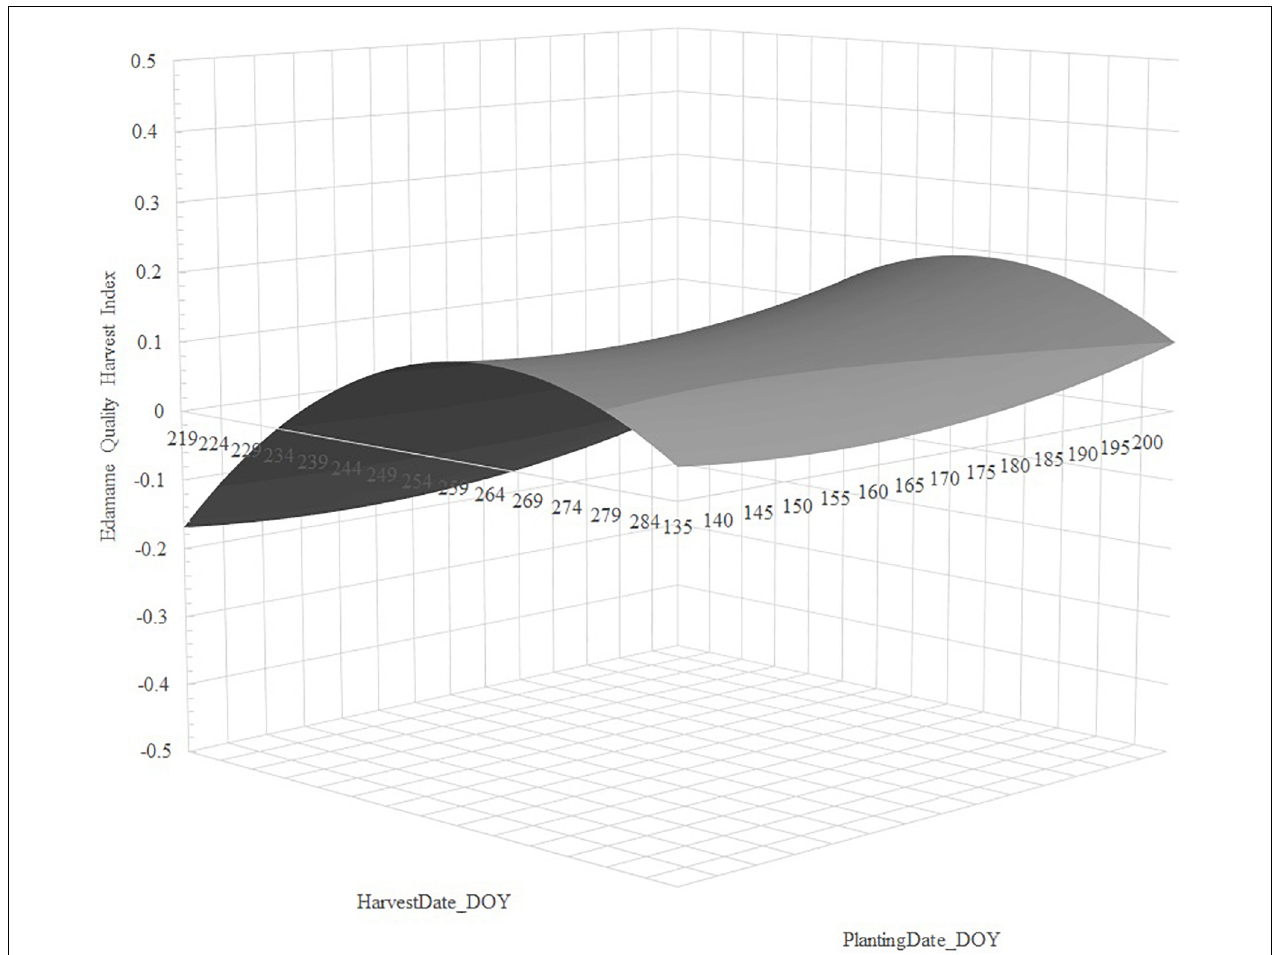
FIGURE 4 | Predicted response of Edamame Harvest Quality Index ( EHQI ) for cultivar R09-345 as a function of the regression of EHQI on PlantingDate_DOY , PlantingDate_DOY 2 , HarvestDate_DOY , and HarvestDate_DOY 2 . Stepwise regression calculated from dataset of edamame cultivar R09-345 planted on two Arkansas locations over 2 years in three planting dates and subjected to up to eight harvest dates, approximately 5 days apart, between R5.8 and